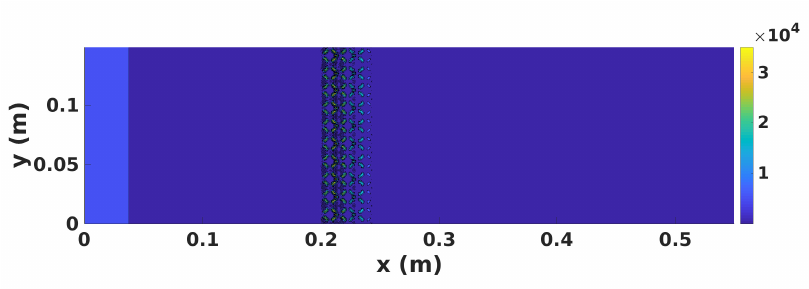
(cid:12) (cid:12) (cid:12) (cid:12) − p recons (cid:12) p ref (cid:12) (Pa) - N s = 10 - s